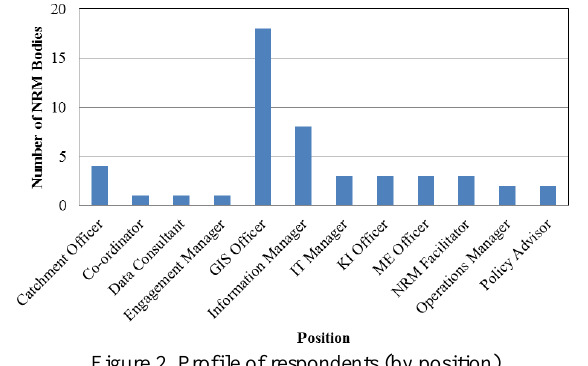
Figure 2. Profile of respondents (by position)